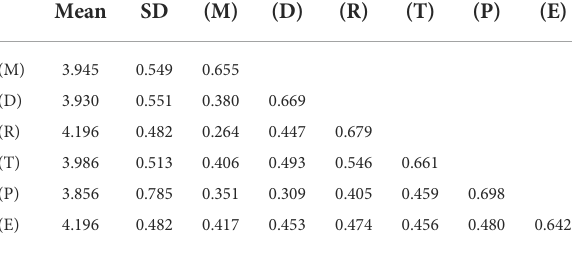
TABLE 4 Analysis results of Fornell-Lacker